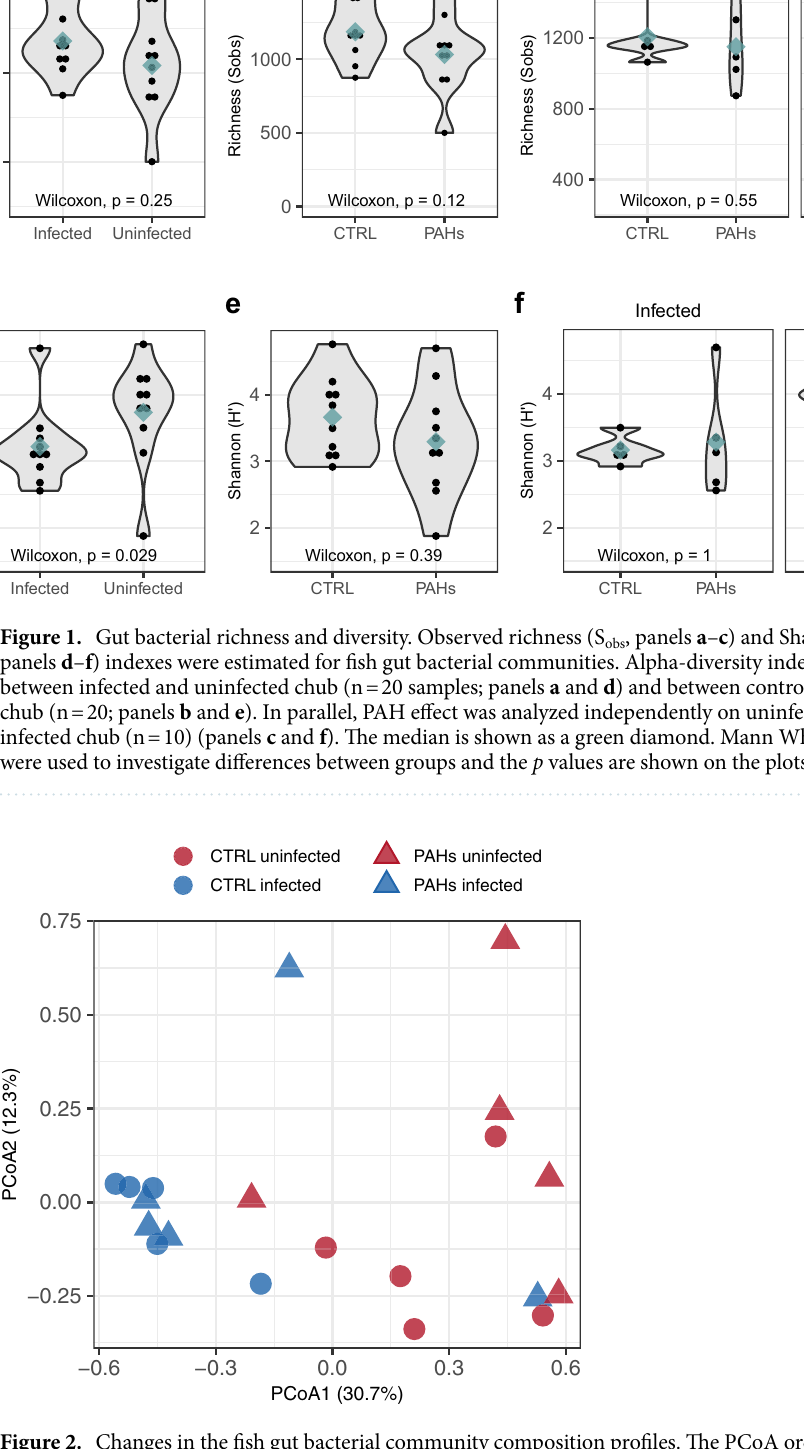
Figure 2. Changes in the fish gut bacterial community composition profiles. The PCoA ordination is based on the Bray–Curtis dissimilarity metric. The shape of the symbols refers to PAH exposure: round for controls and triangular for PAH-exposed fish. The color refers to the parasitic status of the host: red for uninfected chub and blue for infected